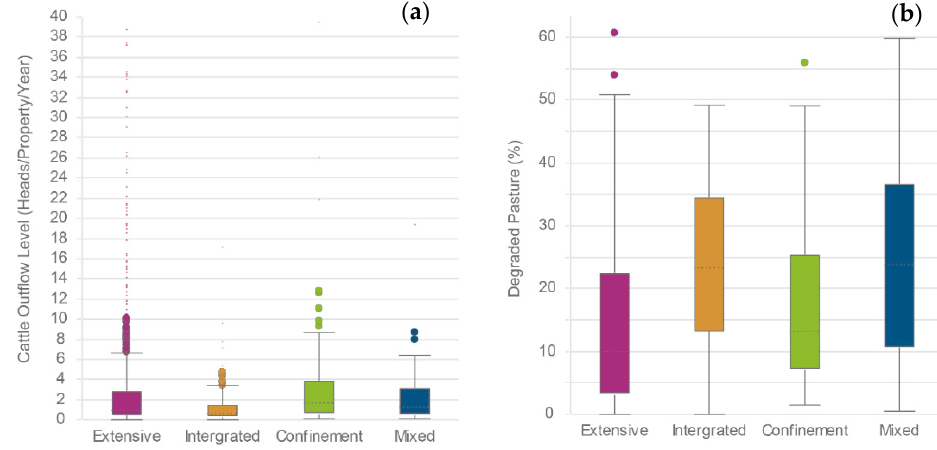
Figure 6. Complementary variables used to characterize cattle production in high-volume suppliers ( a ) cattle outflow level and ( b ) degraded pasture.